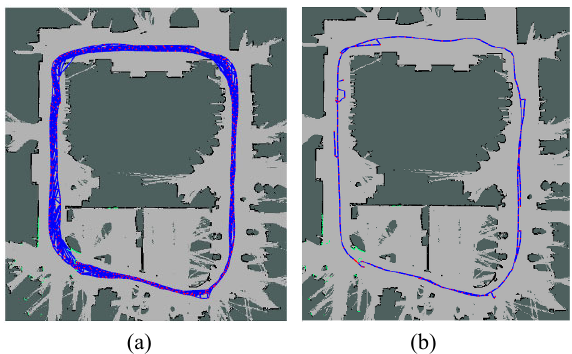
Fig. 7 Pose-graph. The red point is the robot pose and the blue line is the robot trajectory: (a) pose graph without check step and (b) pose graph with check stop.